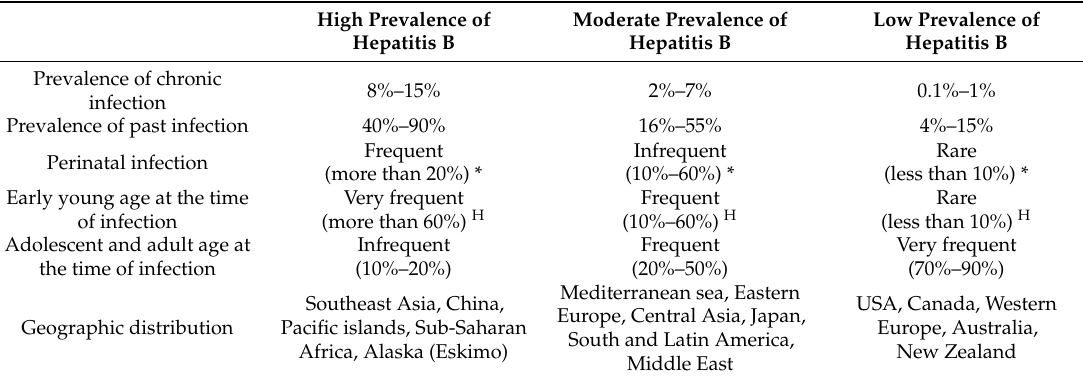
Table 1. Prevalence of hepatitis B worldwide (adjusted according to